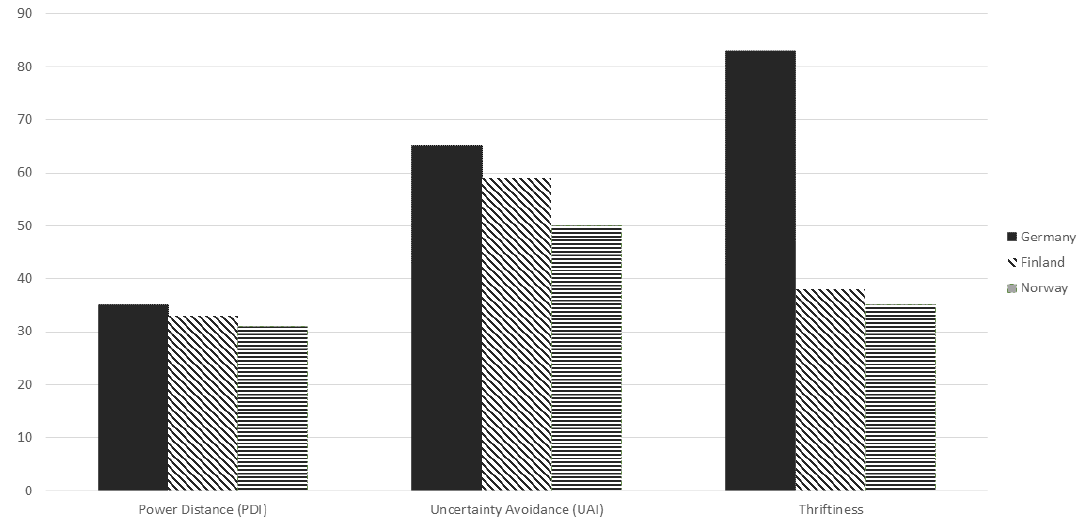
Figure 2. Cross-cultural scores of Germany, Finland and Norway (data source: [125]) .